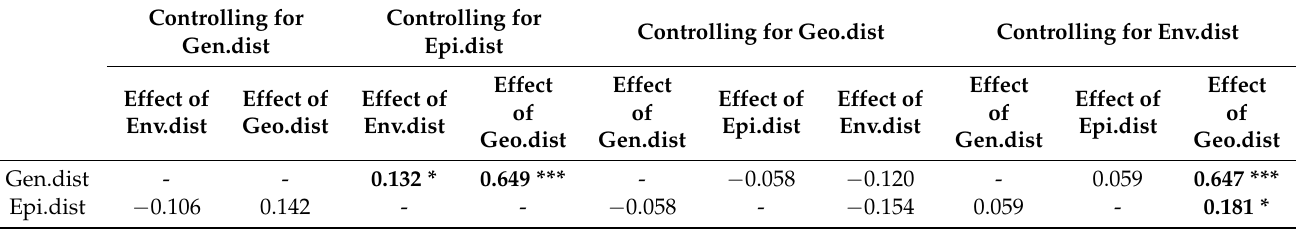
Table 5. Partial Mantel tests were conducted to compare the relative effects of environment and spatial distance on genet- ics and epigenetics.